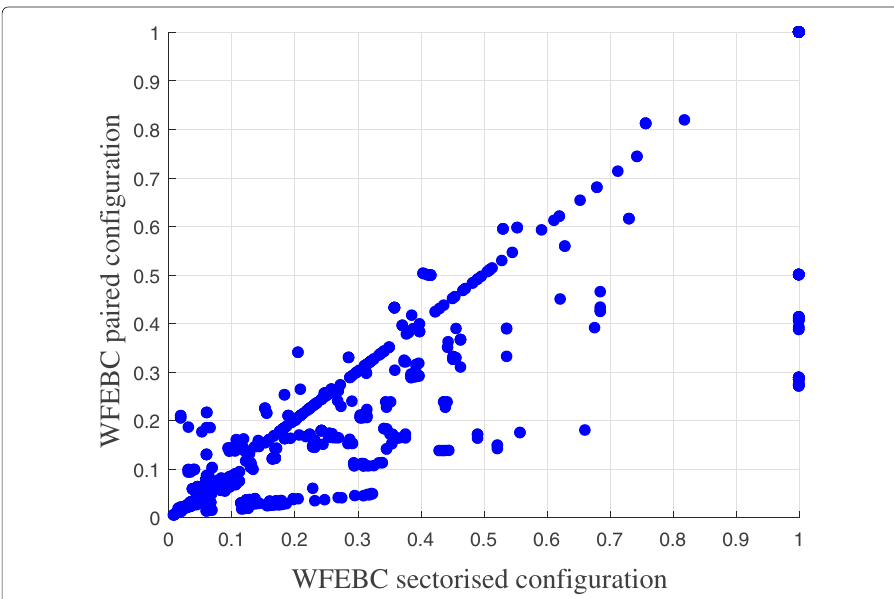
Fig. 13 Comparison of link WFEBC values in the paired DMA configuration of BWFL against the sectorised configuration. The average decrease in FEBC indicates an improvement with regards to resilience in the paired configuration compared to the sectorised